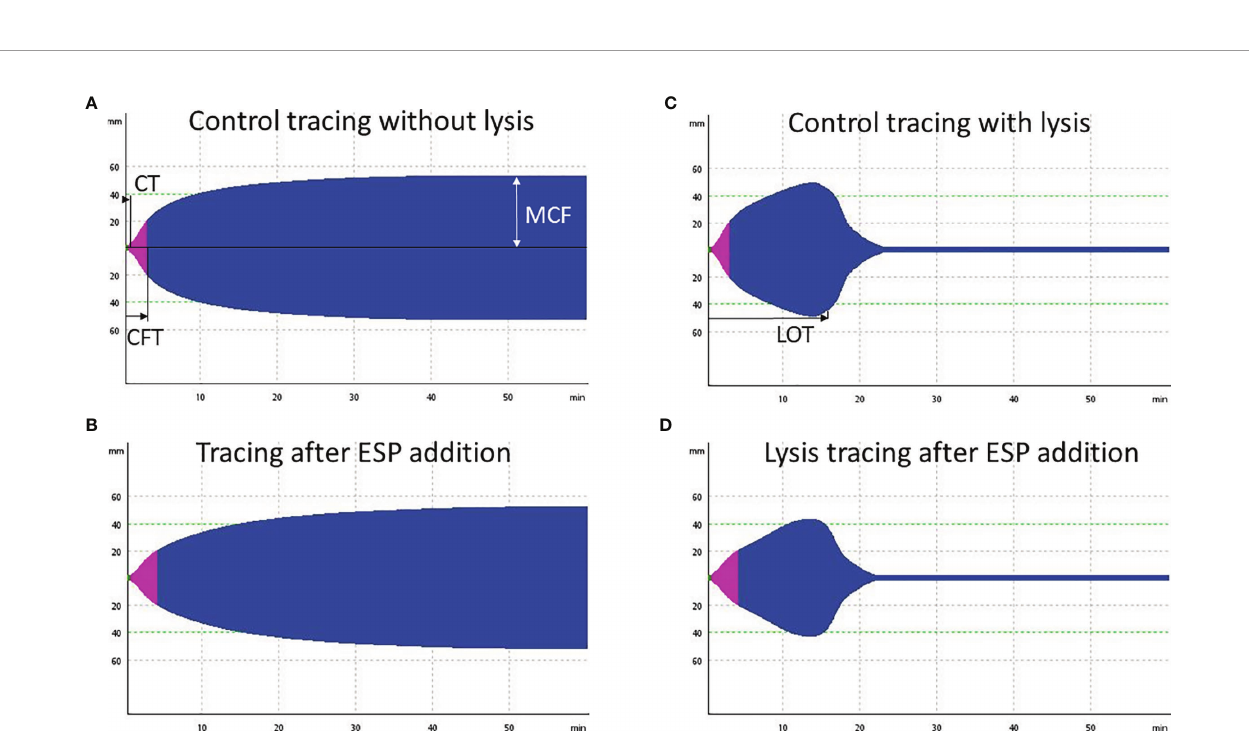
FIGURE 6 | Four exemplary rotational thromboelastometry (ROTEM) EXTEM tracings from dog O. (A) Control tracing, incubation for 1 h with PBS and addition of 0.03 m g/ml tissue plasminogen activator (tPA): regular clot formation time (CFT) within 114 seconds. (B) Decreased clot fi rmness (MCF) by 6 mm (11%), and prolonged CFT (187 seconds) after addition of 10 m g/ml Angiostrongylus vasorum excretory/secretory proteins (ESP) and incubation for 1 h (including 0.03 m g/ml tPA). (C) tPA (0.33 m g/ml) induced fi brinolysis in the same sample as displayed in (A) , with a lysis onset time (LOT) of 815 seconds. (D) Slightly prolonged LOT of 850 seconds after addition of 10 m g/ml ESP to the same sample as in (C)